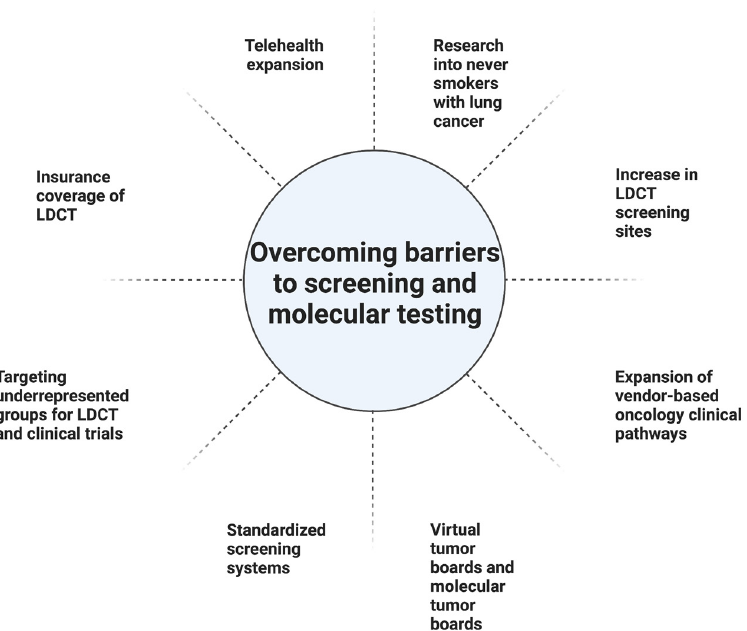
Figure 2. Listed is a summary of strategies that can be implemented to overcome barriers to screening and molecular testing. Created with BioRender.com accessed on 3 February